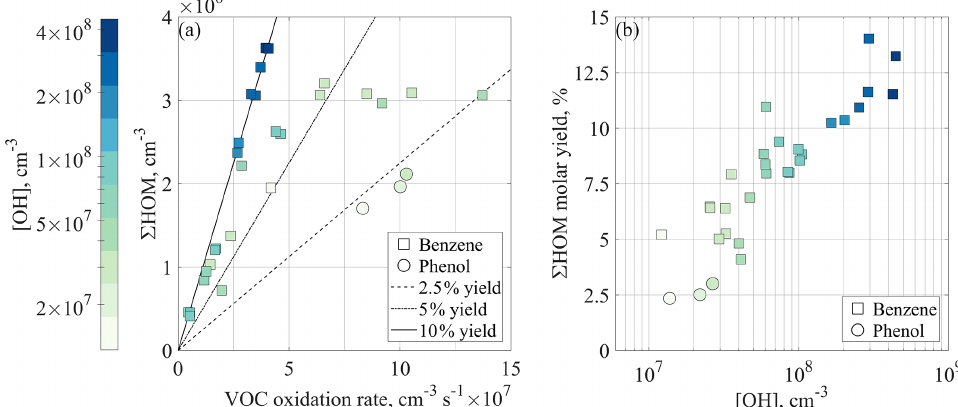
Figure 4. HOM concentrations and yields observed in the JPAC experiments. (a) Total HOM concentration plotted as a function of VOC oxidation rate. If the HOM loss rate is constant between the experiments, conditions with the same molar HOM yields should fall on the same lines. The included lines (for 2.5%, 5%, and 10% yields, respectively) neglect the condensation sink (CS) and depict the yields in the case where loss to walls is the only sink for HOMs. The colour represents the concentration of hydroxyl radicals, squares depict benzene runs, while circles show phenol runs. (b) Calculated HOM molar yields as a function of OH concentration in the chamber corrected for CS. Markers are the same as in panel (a) , as is the colour code for easier